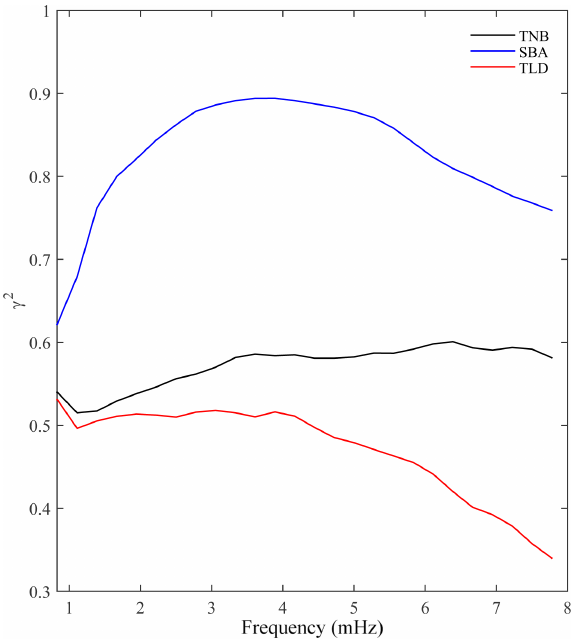
Figure 3. Average multiple coherence between vertical and hori- zontal components for inland (red line) and coastal (black and blue lines) ground